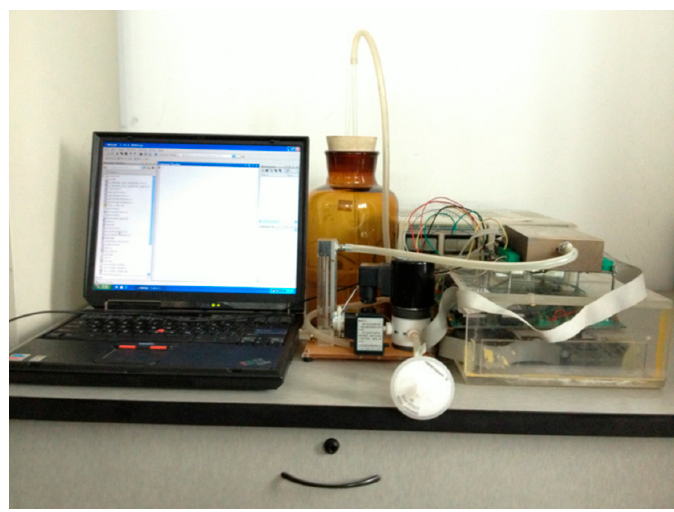
Figure 2. Practical E-nose system. Table 1. Pathogens in wound infection and their